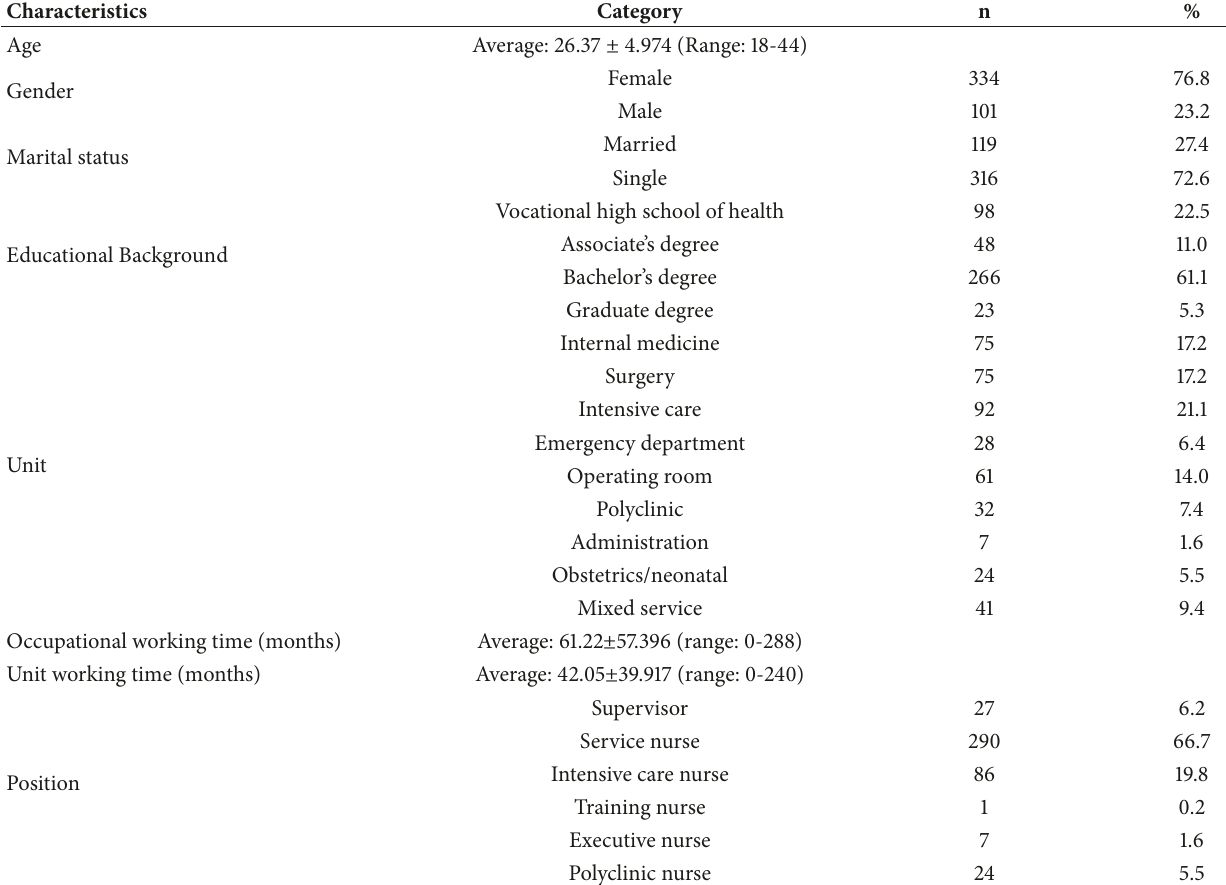
Table 1: Distribution of nurses according to sociodemographic